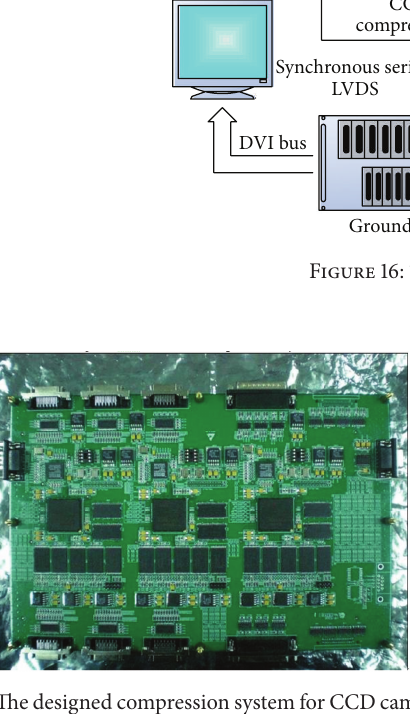
Figure 17: The designed compression system for CCD camera using our PT-CS algorithm.